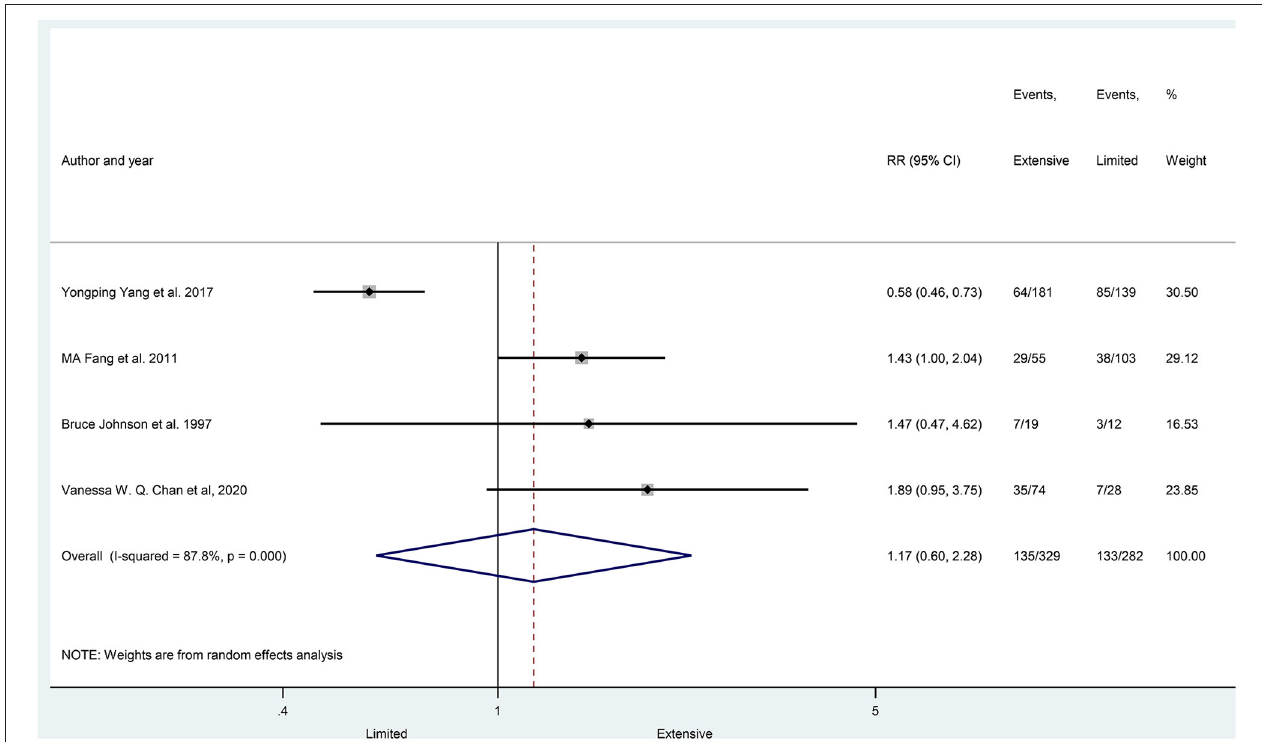
FIGURE 6 | The prevalence of hyponatremia in patients with SCLC having limited and extensive disease stage. Black diamonds represent the individual effects of studies, and vertical lines show the corresponding 95% CI. The size of the gray squares reflects the individual weight of a particular study. The blue diamond shows the overall or summary effect. The outer edges of the diamonds represent the Cis. SCLC, small cell lung cancer, RR, risk